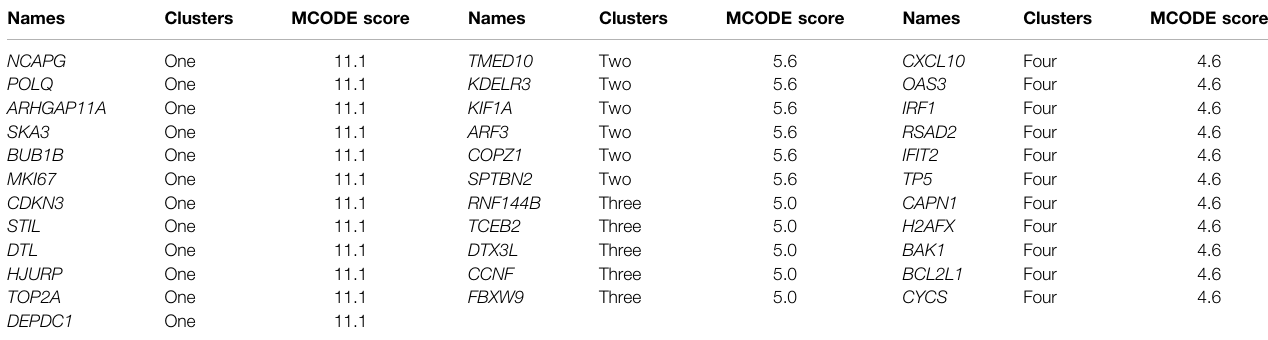
TABLE 2 | 34 target genes from the four